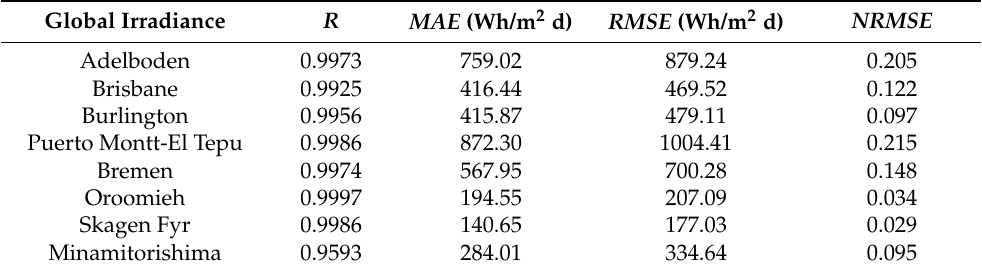
Table 5. Errors and correlation coefficient of monthly average values of daily global irradiance (through the years from Table 4, column “Radiation